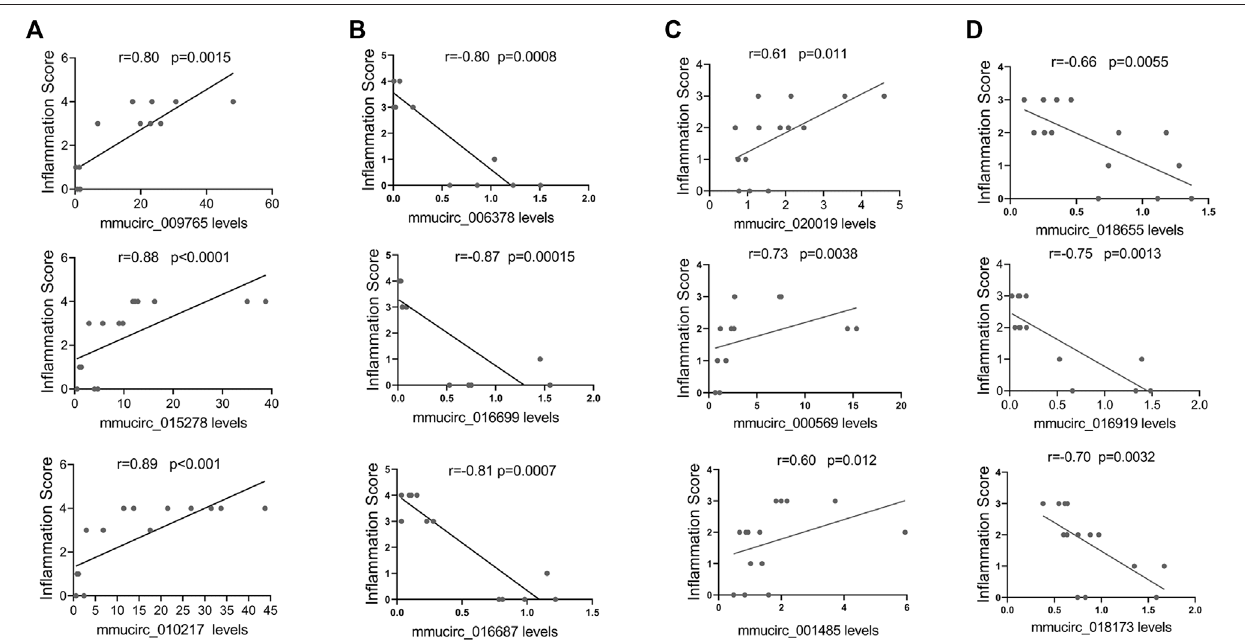
FIGURE 3 | Correlation between circRNAs expression levels and cardiac in fl ammation. (A) The correlation between A/J-speci fi c upregulated circRNAs (mmucirc_009765, mmucirc_015278, mmucirc_010217) and in fl ammatory response, N > 12. (B) The correlation between A/J-speci fi c downregulated circRNAs (mmucirc_006378, mmucirc_016699, mmucirc_016687) and in fl ammatory response, N > 12. (C) The correlation between C57BL/6-speci fi c upregulated circRNAs (mmucirc_020019, mmucirc_000569, mmucirc_001485) and in fl ammatory response, N > 12. (D) The correlation between C57BL/6-speci fi c downregulated circRNAs (mmucirc_018655, mmucirc_016919, mmucirc_018173) and in fl ammatory response, N > 12.